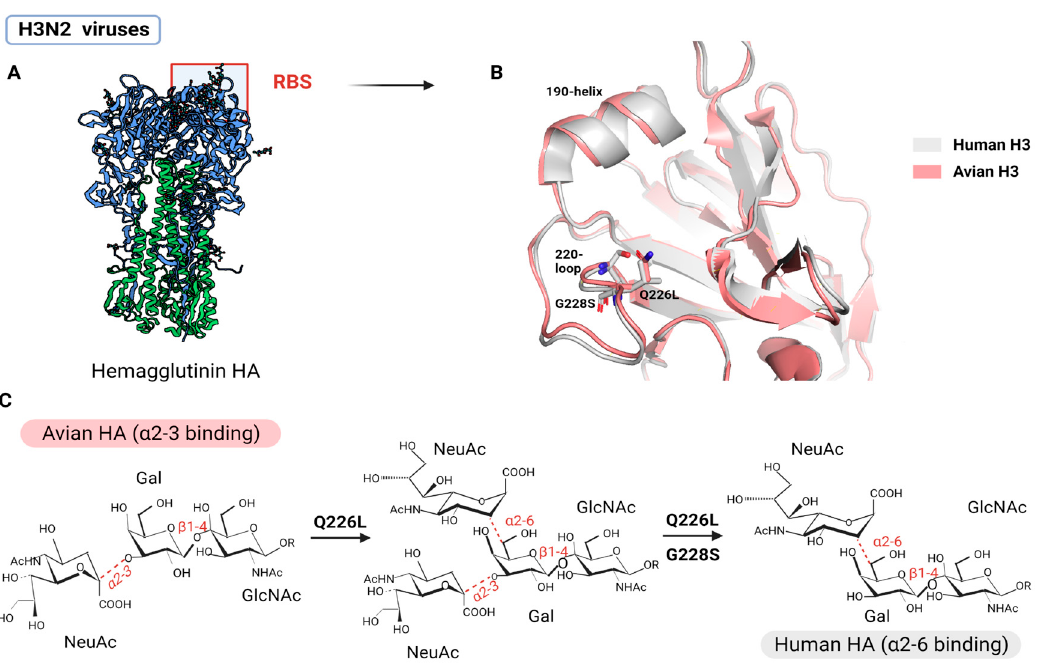
Figure 5. Q226L and G228S substitution in H3N2. ( A ) Overall trimeric structure of HA of IAV H3N2. The location of RBS is marked. ( B ) Comparison of the structural characteristics and amino acid positions of avian (pink) and human (white) H3 RBS proteins. ( C ) The impact of specific receptor- binding variants on viral receptor specificity that facilitated the entry of H3N2 into the human cells. Adapted from ref. [101]. Created using Pymol (Schrodinger LLC) with PDB IDs 6TZB and 1MQM, and with BioRender.com (accessed on 18 March 2023).